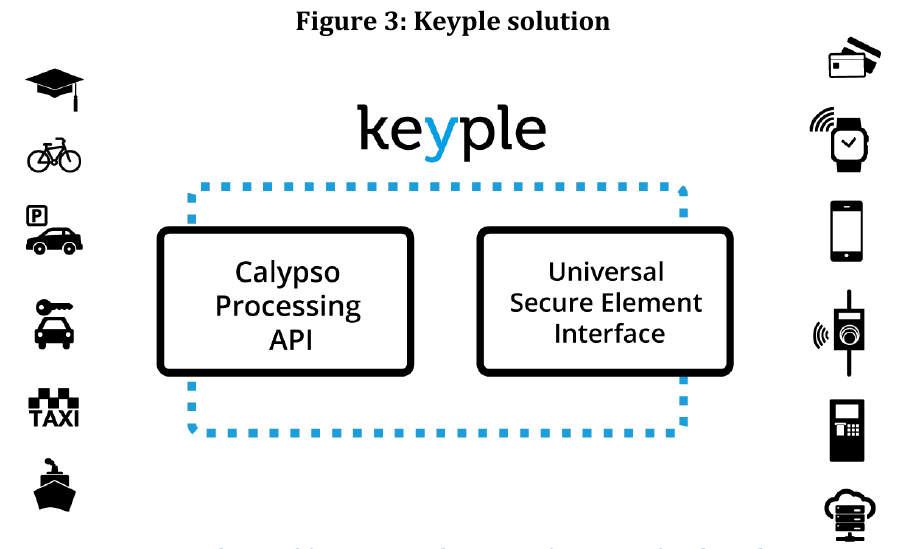
Figure 3: Keyple